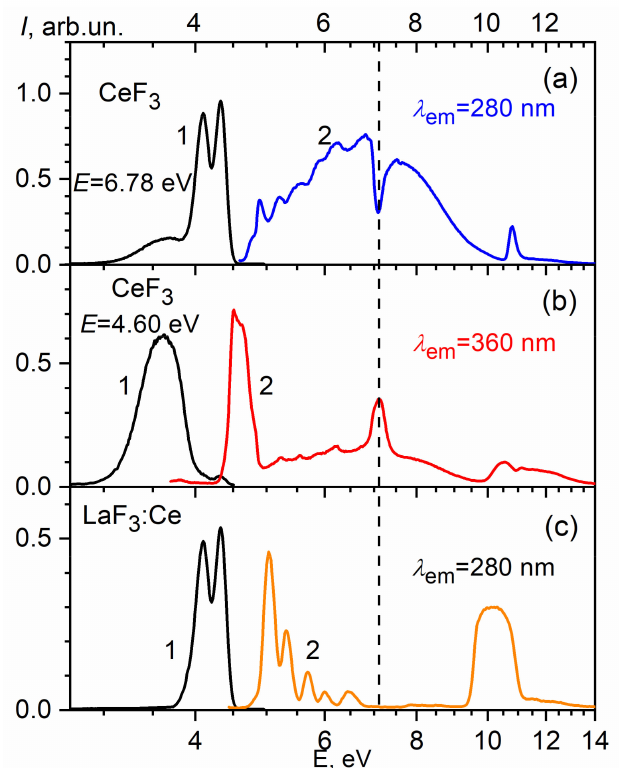
Figure 4. Luminescence (1) and luminescence excitation spectra (2) for: ( a ) cerium excitons in CeF 3 ;